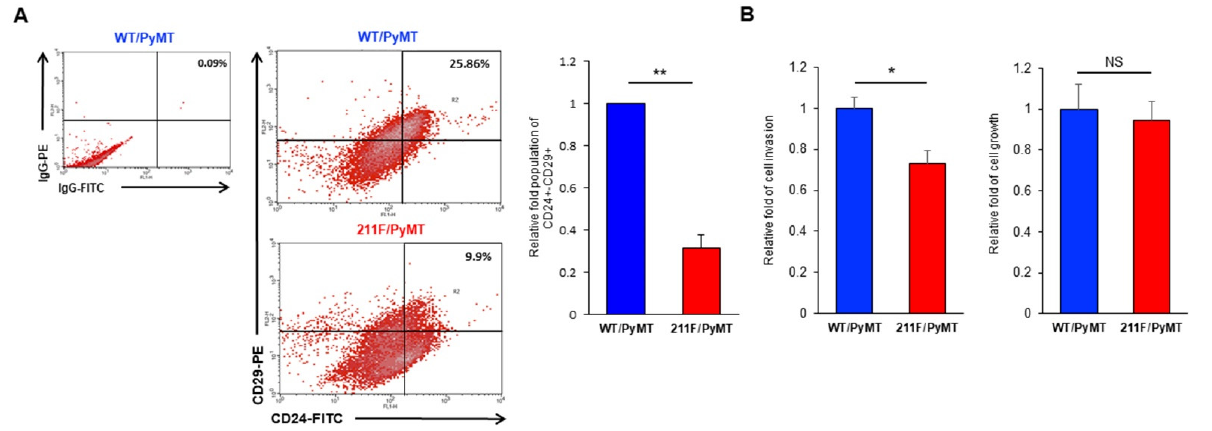
Figure 2. Increased stemness markers in WT/PyMT tumors. ( A ), Expression of the cancer stemness markers CD24 and CD29 in PyMT-tumor derived cells was determined by flow cytometry. Quantification results and representative plots are shown. The isotype control IgG antibodies were employed to exclude non-specific staining. Bar, standard deviation. **, p < 0.01 by Student’s t − test. ( B ), Cell invasion and migration were quantitated and showed that the WT/PyMT cells had higher invasion ability but no difference in cell growth compared to the 211F/PyMT cells. Bar, standard deviation. *, p < 0.05 by Student’s t − test. NS, non - significance.